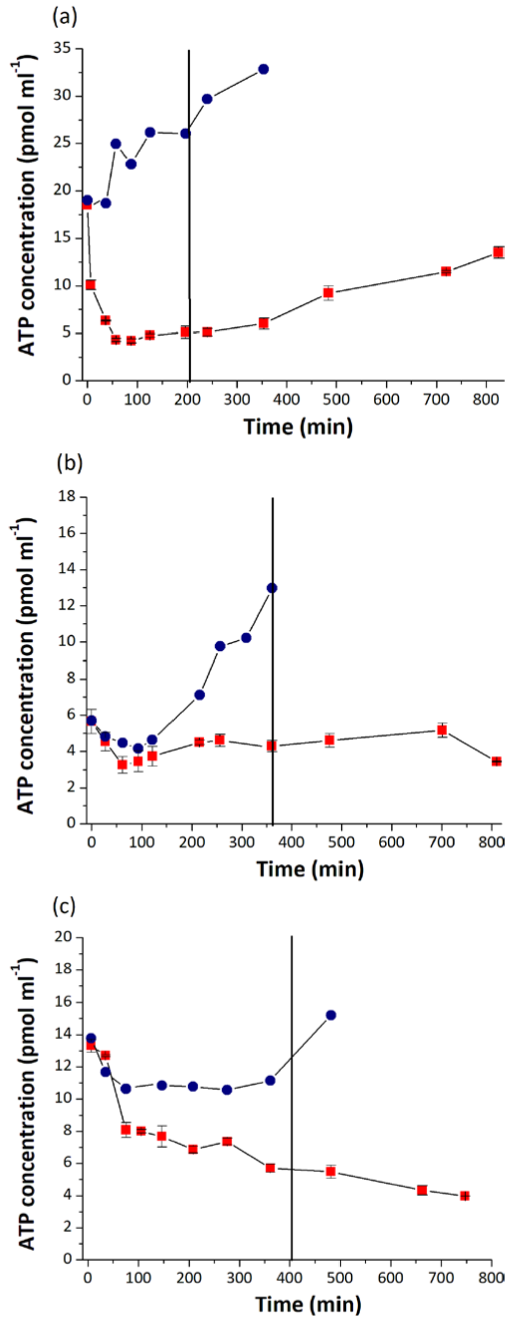
Figure 2. ATP concentration (µM) as a function of time (min) in the presence (red square) or absence (navy circle) of H 2 O 2 for the three strains: (a) Pseudomonas graminis (13b-3), (b) Pseudomonas sy- ringae (13b-2), and (c) Sphingomonas sp. (14b-5). The vertical bar illustrates the time corresponding to the total degradation of H 2 O 2